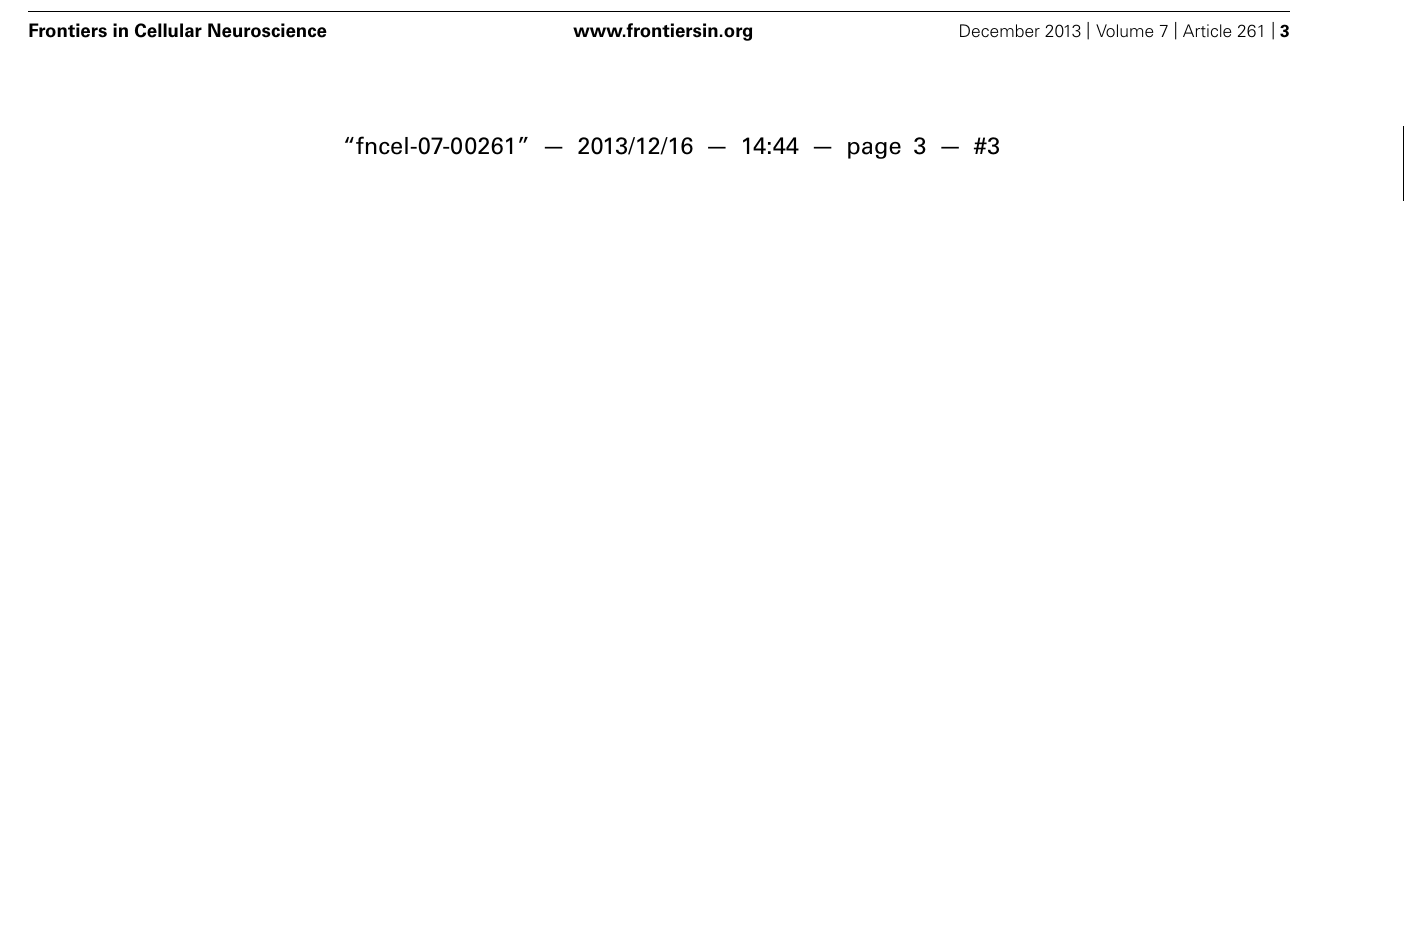
cells were primed with 10 μ M BrdU for 24 h, fixed and stained with markers to label mature oligodendrocyte (O4), OPC (PDGFR/O4), astrocytes (GFAP + /BrdU − ), neurons ( β III tubulin), and total proliferating cells (BrdU). Results are expressed as a percentage of stained cells vs. total cells, counterstained with DAPI. Counts represent means ± SEM ( n = 3 independent experiments, five fields in each). ∗∗ p < 0.01, ∗ p < 0.05 vs.